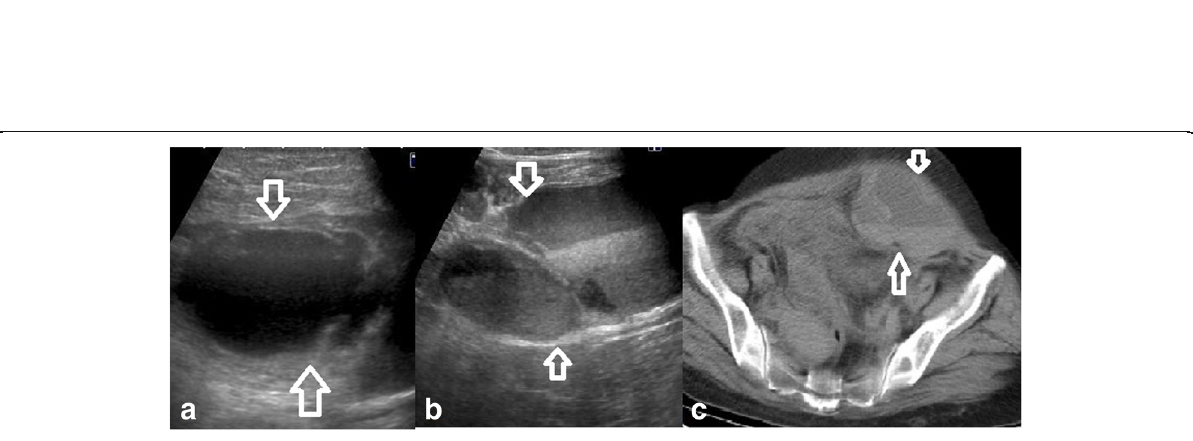
Fig. 8 a – c Ultrasound and CT images for a case of rectus sheath hematoma. a An ultrasound image showing anechoic (cyst-like) lesion implicating the left rectus abdominus muscle (between the white arrows). b An ultrasound image for the same patient at a lower level showing internal septations with layering low-level internal echoes, and possible fluid levels were seen likely due to cellular sedimentation (between the white arrows). c An axial CT image confirming the findings that were present in a and